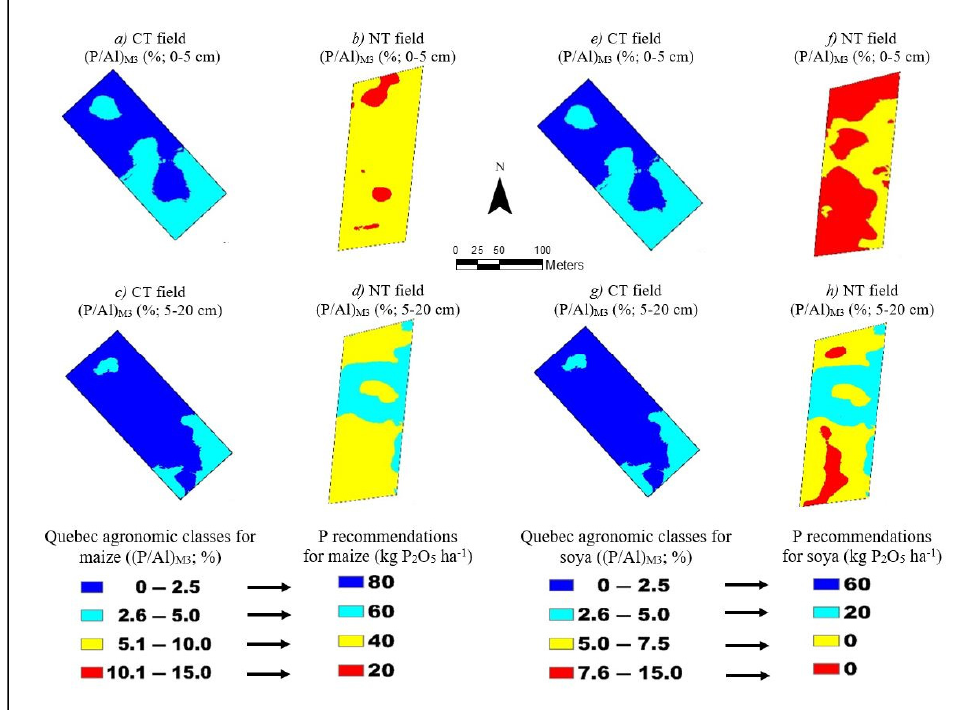
Figure 5. Quebec agronomic classes (P/Al) M3 and the corresponding accurate P recommendations (kg P 2 O 5 ha − 1 ) for maize and soya in the conventional and no-tillage fields. Table 5. Accurate P fertilizer recommendations (kg P 2 O 5 ) calculated for a maize–soybean rotation based on the kriged value (P/Al) M3 of each specific area (A) compared to the mean value (P/Al) M3 from two soil layers (0–5 cm and 5–20 cm) in the conventional and no-tillage fields.